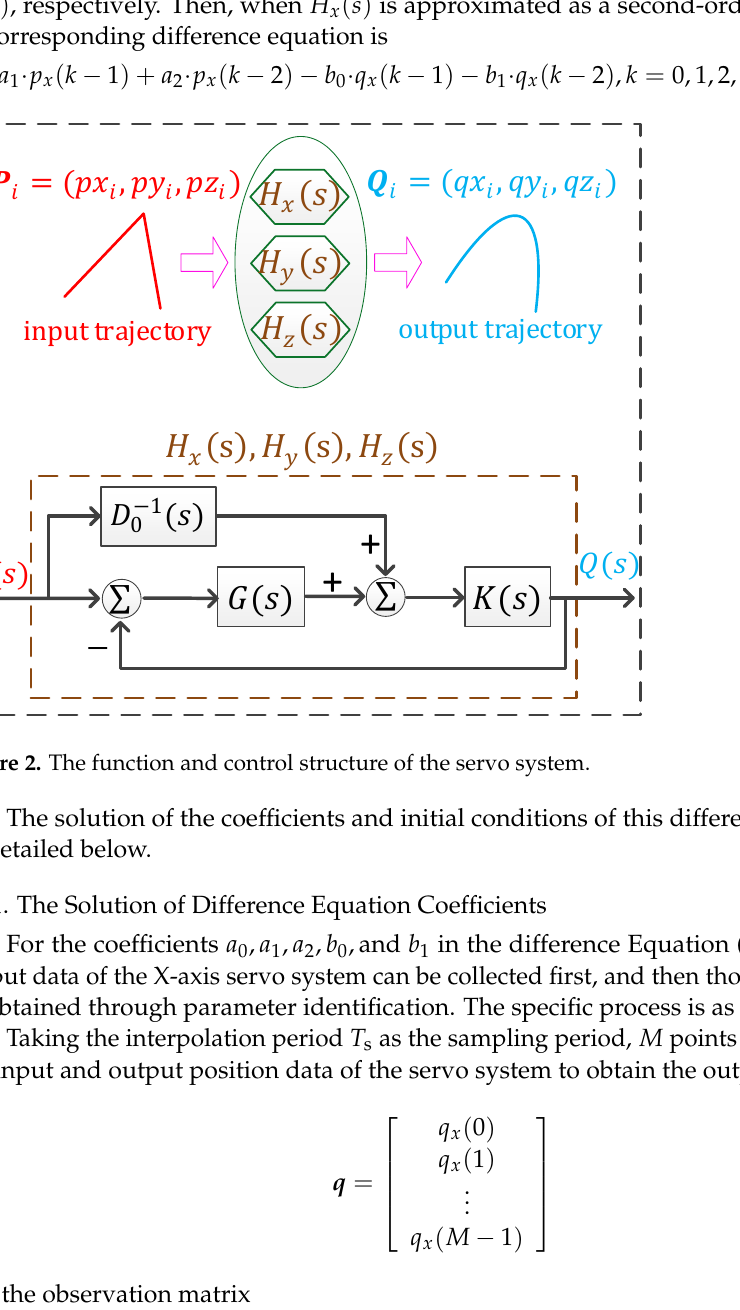
of the servo system i